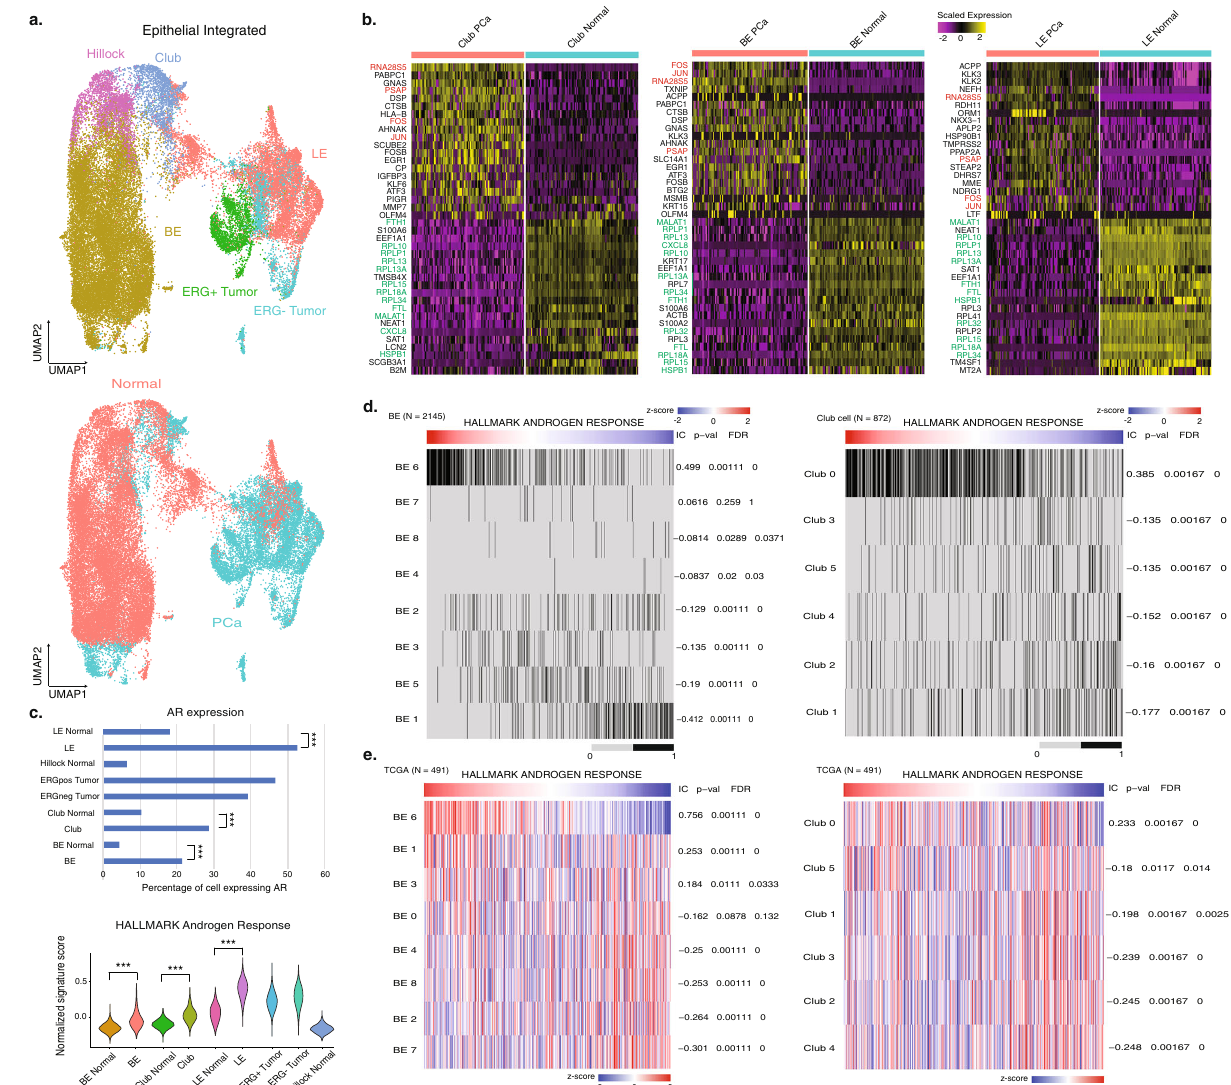
Fig. 5 Integration of PCa and normal epithelial cells reveals common AR signaling upregulation driven by PCa-enriched BE and club cell states. a UMAP of integrated epithelial cells annotated by cell types and sample type (PCa and Normal), then separated by the origin (either previous normal epithelial cells or epithelial cells in the PCa samples). b Heatmaps of top 20 differentially expressed genes between PCa samples and normal prostates for adjacent cell types (left: BE PCa, BE Normal. Middle: Club Normal, Club PCa. Right: LE PCa, LE Normal). Commonly upregulated genes in the PCa samples are labeled in red, and commonly upregulated genes in the normal samples are labeled in green. c Top, AR expression percentages in all epithelial cell types within the integrated dataset. Signi fi cance levels are labeled in each comparison (*** P < 0.001, two-sided Fisher ’ s exact test; BE: P = 1.49e-145; LE: P = 1.25e-184; Club: P = 1.61e-27). Bottom, Comparison of Hallmark AR pathway signature scores of each epithelial cell type. Signi fi cance levels are labeled for each common cell type (*** P < 0.001, Wilcoxon rank-sum test; BE: P < 2.2e-16; LE: P = 4.21e-295; Club: P = 1.45e-253). d The association of AR signature with BE and club cell state. Each cell is labeled (gray: 0, not in the cell state; black: 1, in the cell state). Information coef fi cient accompanied P values and FDR q values are labeled next to each cell state. e The association of AR signature with BE and club cell-state signature scores in the TCGA datasets ( N = 491). Information coef fi cient accompanied P values and FDR q values are labeled next to each cell state. Source data are provided as a Source Data fi